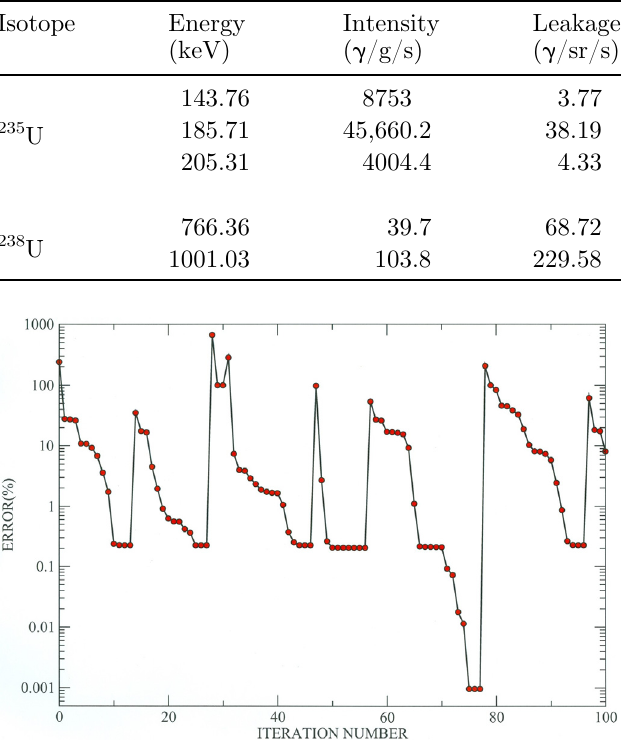
Fig. 13. Evolution of the error metric with the number of